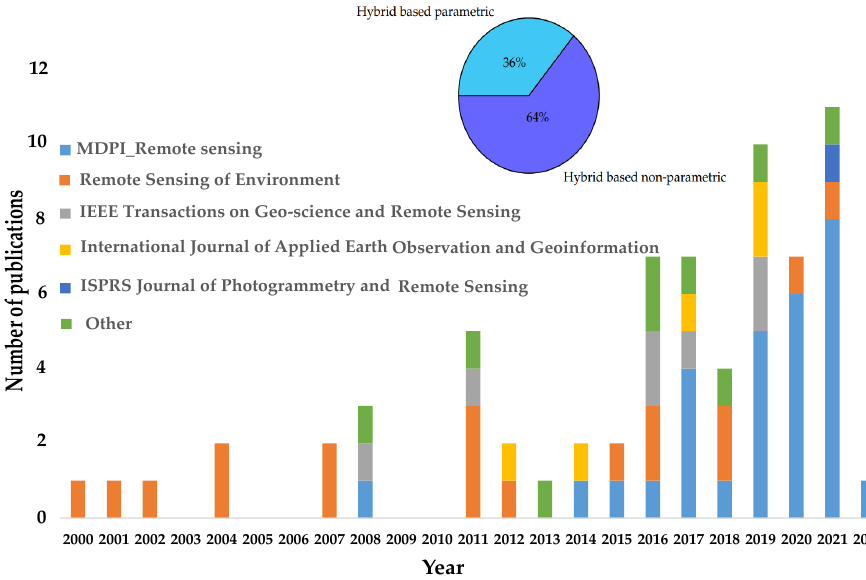
Figure 5. ( Lower part ) Bar chart showing the number of studies versus the annual number of pub- lished papers in different journals from 2000 to 2022. ( Upper part ) Pie chart showing the percentage of published papers applied for nonparametric compared to parametric methods based on the radiative transfer model (RTM)